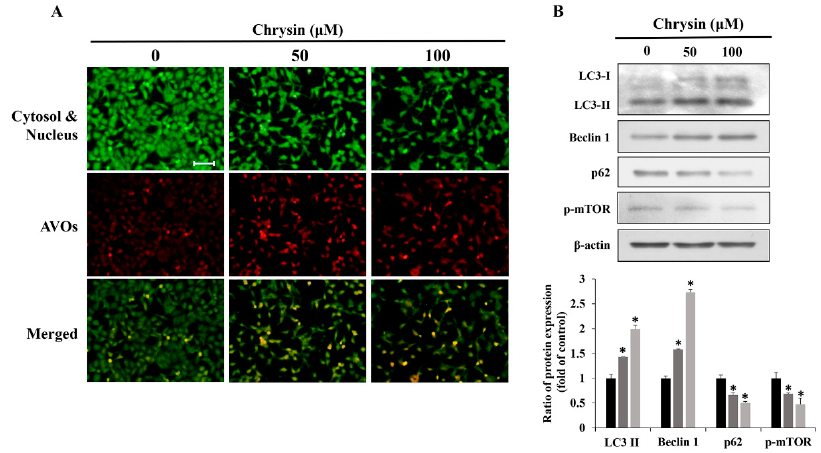
Figure 3. Chrysin induces autophagy in MC-3 oral cancer cells. ( A ) Fluorescence microscopy image of acidic vesicular organelles after chrysin treatment. Scale bar = 10 µm. The cytosol and the nucleus are stained fluorescent green, and the AVOs are stained fluorescent red. ( B ) The levels of the autophagy-related proteins light chain 3, B-cell lymphoma-2-interacting protein (Beclin-1), p62 and p-mammalian target of rapamycin (mTOR). Quantification was performed using Image J. The results are presented as the means and standard deviation of three independent samples. The statistical differences were determined by the Dunnett’s t -test: * p < 0.05, compared with the control.